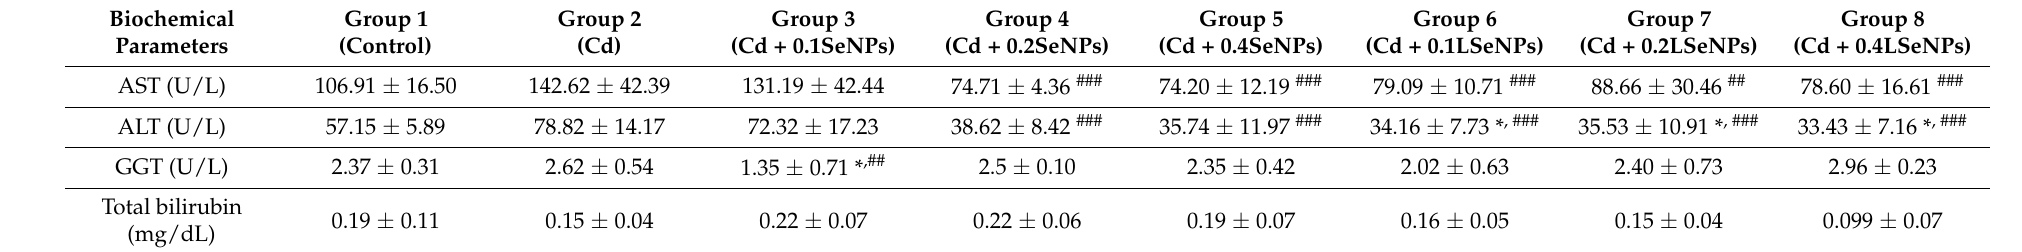
Table 2. Effects of cadmium and selenium on biochemical parameters after 30 days treatments 1